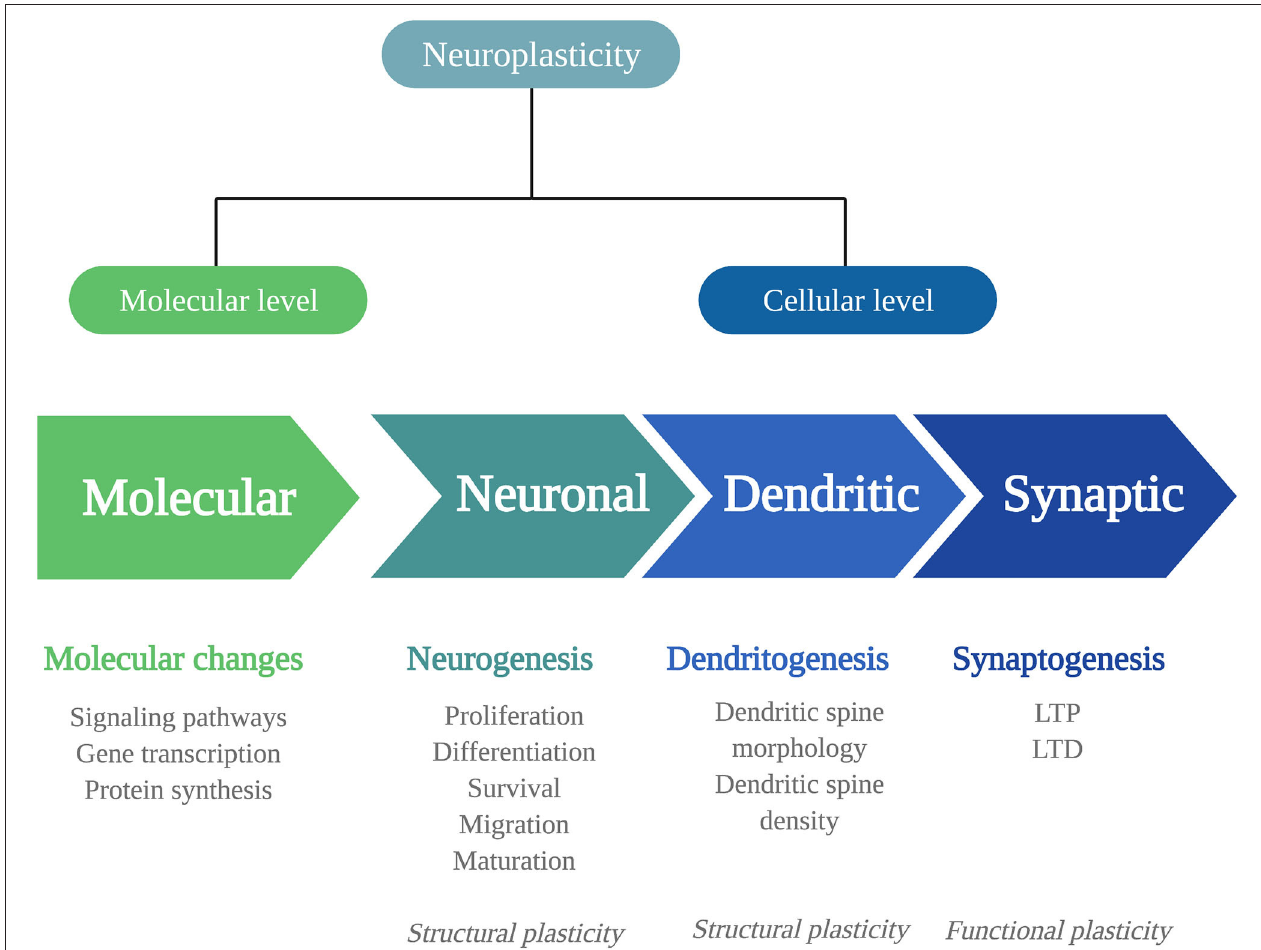
FIGURE 1 | Mechanisms of neuroplasticity. Schematic representation of the different mechanisms of neuroplasticity at a molecular and (sub)cellular level. Neuroplasticity at a molecular level affects intracellular signaling pathways, gene transcription, and protein synthesis. At a cellular level, neuroplasticity occurs at the subcellular levels of neurogenesis, dendritogenesis, and synaptogenesis. The neuronal changes of neurogenesis and dendritic changes alter the structural characteristics of the neuron: structural plasticity. Synaptogenesis involves functional changes: functional plasticity. LTP, long-term potentiation; LTD, long-term